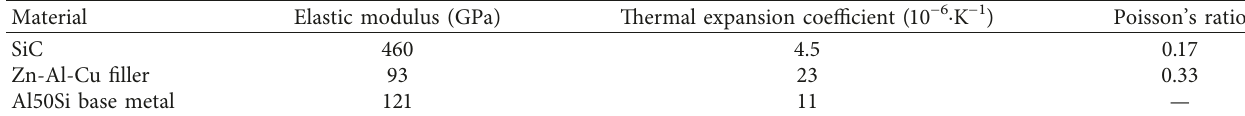
Table 1: Physical properties of SiC particles, Zn-Al-Cu filler metal, and Al50Si base metal. Material Elastic modulus